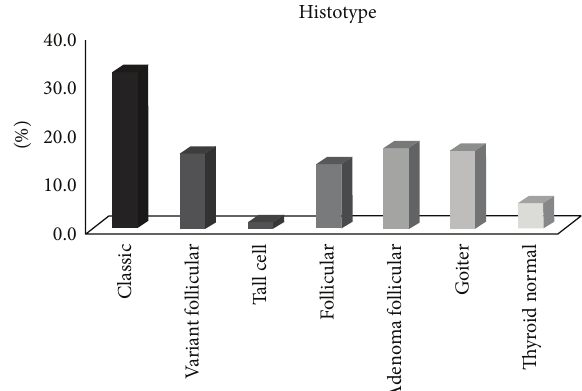
Figure 1: Histological types distributed in